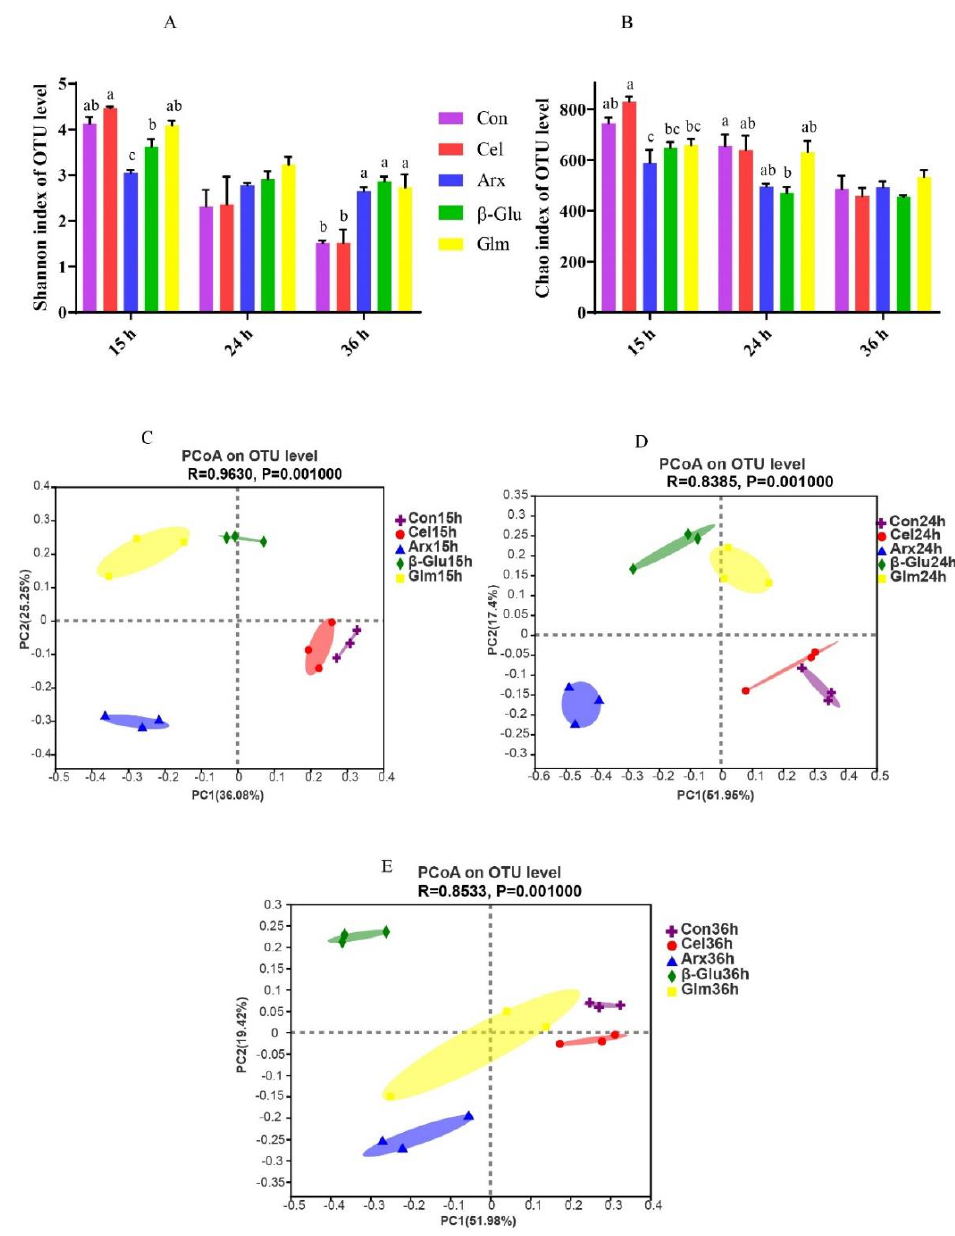
Figure 2. Effects of four polysaccharides on bacterial α -diversity (Shannon index, A ; Chao index, B ) and β -diversity (PCoA, 15 h, C ; 24 h, D ; 36 h, E ) in the fermentation broth. The results were analyzed by the Kruskal – Wallis ANOVA test and presented as mean values; PCoA plot based on the Bray – Curtis distance matrix ( n = 3; Different letters mean p < 0.05; Con, control; Cel, cellulose; Arx, arabinoxylan; β − Glu, β − glucan; Glu, glucomannan).